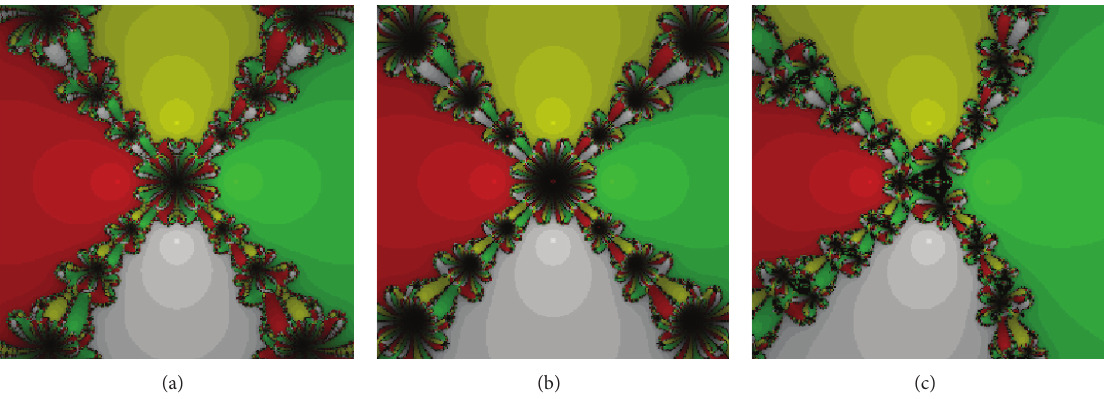
Figure 1: The basins of attraction for CM 1 4 (a), KM 4 (b), and MKM 4 (c) in problem 1.